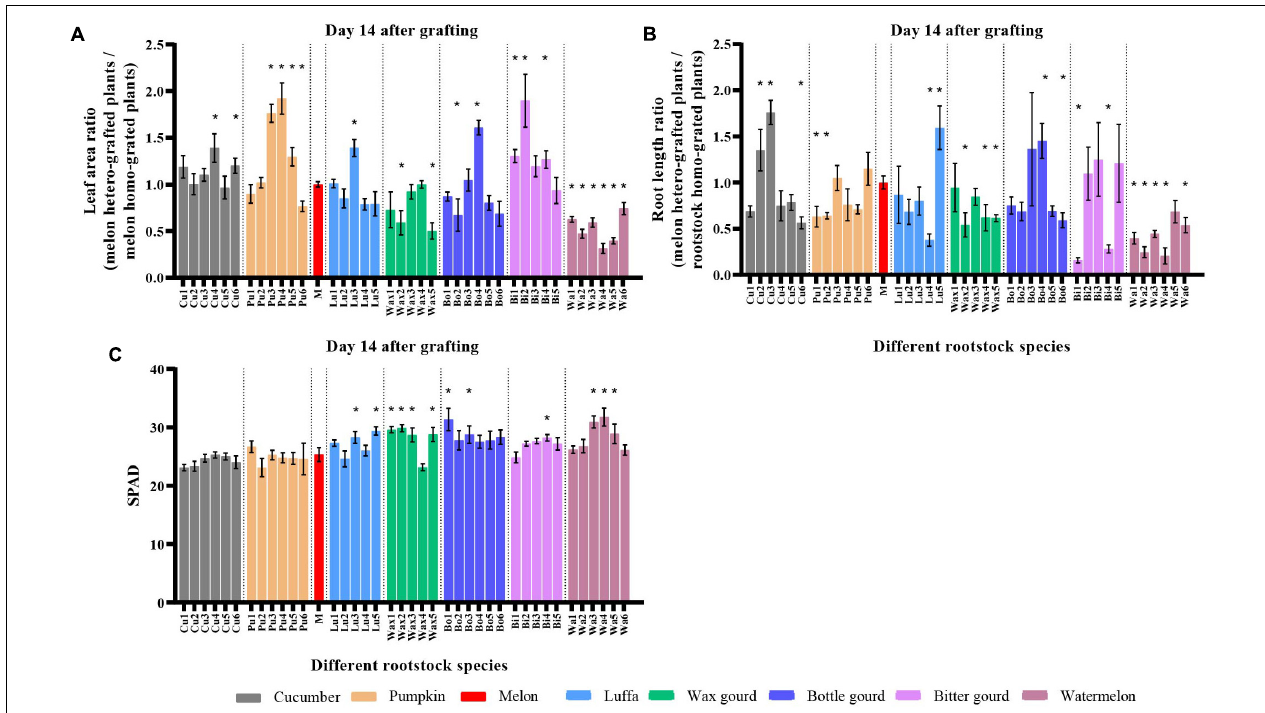
FIGURE 4 | Leaf area, root length, and SPAD of melon grafted onto eight Cucurbitaceae rootstocks on day 14 after grafting. Leaf area ratio ( A , melon hetero-grafted plants/melon homo-grafted plants), root length ratio ( B , melon hetero-grafted plants/rootstock homo-grafted plants), and SPAD ( C , relative chlorophyll value) of melon cv. ‘Akekekouqi’ grafted onto cucumber (Cu1–Cu6), pumpkin (Pu1–Pu6), melon (M), luffa (Lu1–Lu5), wax gourd (Wax1–Wax5), bottle gourd (Bo1–Bo6), bitter gourd (Bi1–Bi5), and watermelon (Wa1–Wa6). Asterisks indicate a significant difference between melon or rootstock homo-grafted plants and hetero-grafted plants using Student’s t -test ( p <